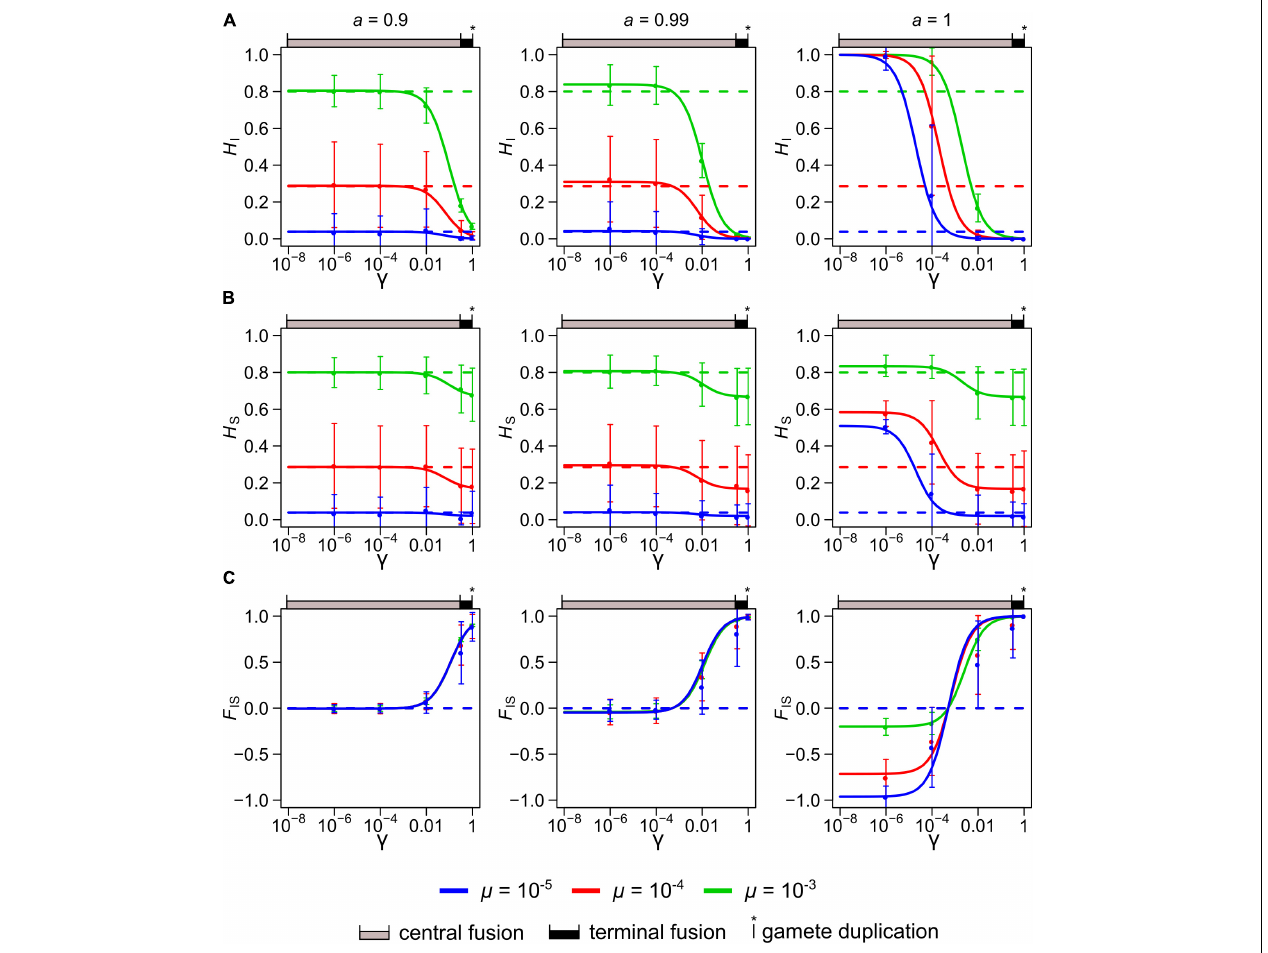
FIGURE 2 | Neutral genetic diversity at equilibrium in a population with a mixed, sexual-automictic, reproductive system represented by three statistics: the individual heterozygosity, H I (A) , the population heterozygosity, H S (B) and the individual inbreeding coefficient, F IS (C) . The solid lines show the theoretical values for these statistics for varying rates of loss of heterozygosity, γ and under three discrete rates of automixis, a (0.9, 0.99, and 1). For each plot, three mutations rates, µ , are shown: 10 − 5 (blue), 10 − 4 (red), and 10 − 3 (green). The dashed lines show the corresponding expected values in purely sexual populations (i.e., where a = 0). Population size was set to N = 1000. The colored circles and the vertical bars represent the mean and standard deviations obtained by simulation for γ = 10 − 6 , 10 − 4 , 10 − 2 , 1/3 and 1. The ranges of γ covered by the three main modes of automixis are indicated above each graph: central fusion automixis in gray (0 ≤ γ ≤ 1/3), terminal fusion automixis in black (1/3 ≤ γ ≤ 1) and gamete duplication automixis ( γ =